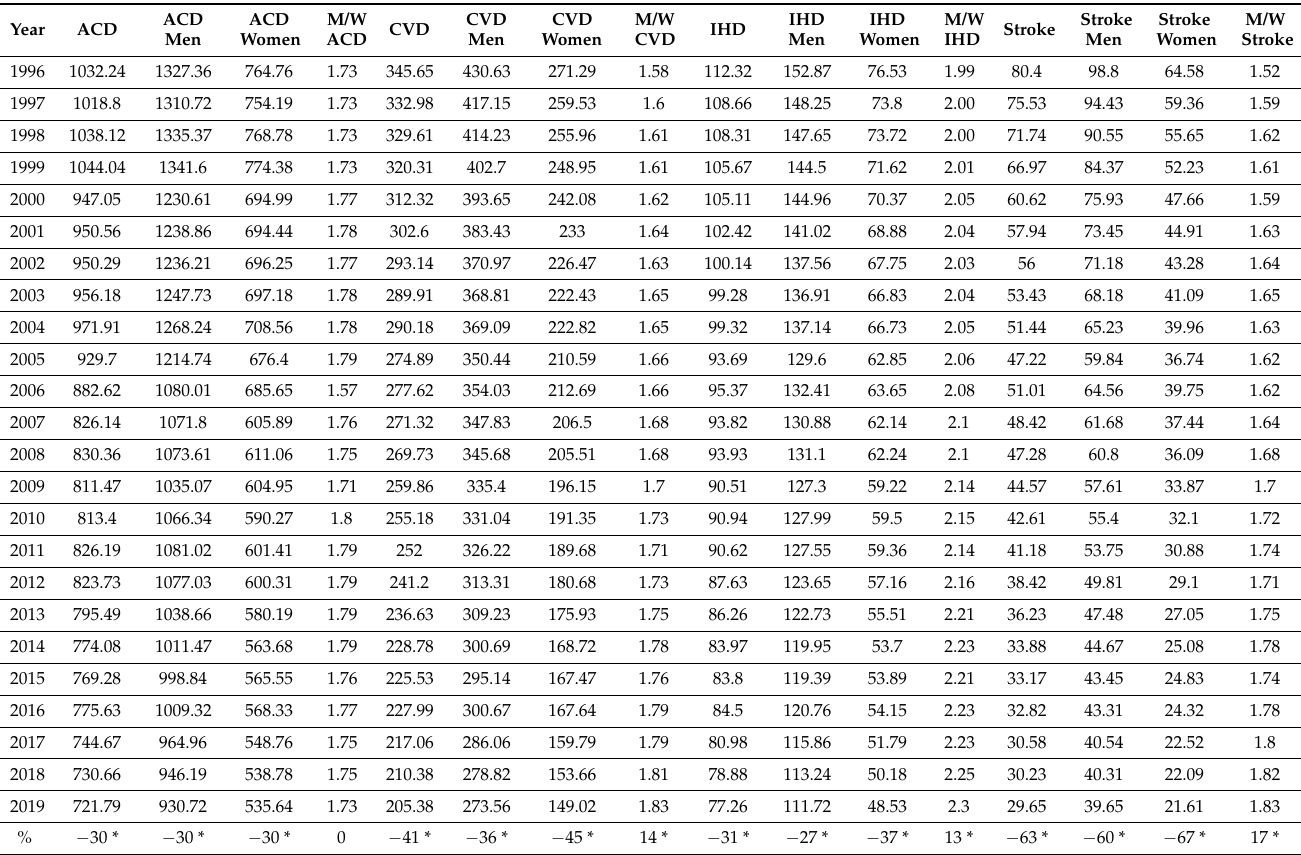
reduction of 39% (CLRLS: men vs. women: p = 0.589) (Table 2). Table 2. Adjusted death rate (DRaj) per 100,000 population for the age group 35 to 74 years of the general population, in men (M) and women (W), from all causes of death (ACD), cardiovascular diseases (CVD), ischemic heart disease (IHD), and stroke per 100,000 inhabitants in Brazil from 1996 to